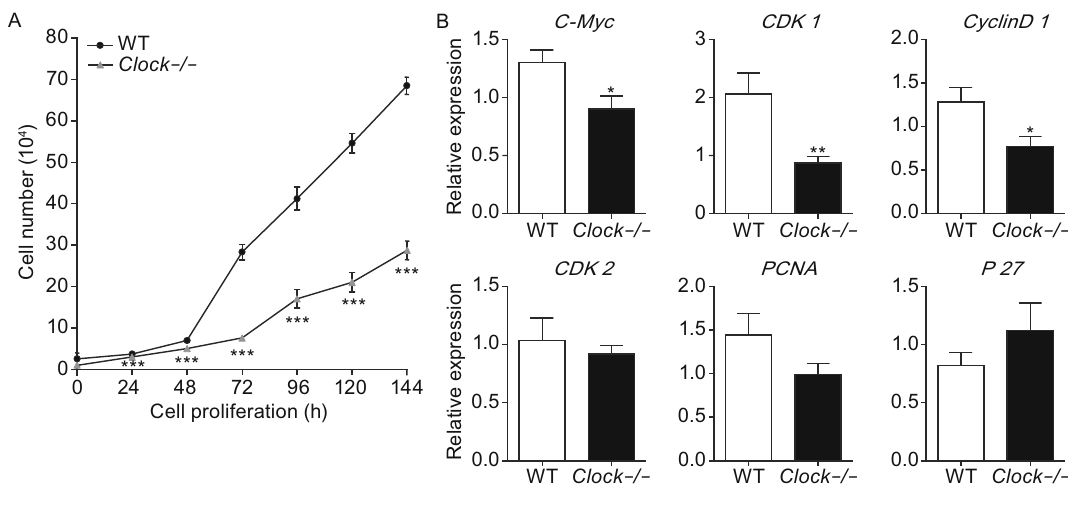
Figure 4. Clock silencing inhibited proliferation of mESCs. (A) Cell proliferation curve of the wild type and Clock -/- mESCs. Clock -/- mESCs exhibited signi fi cantly lower proliferation rate than that of the wild type mESCs. (B) Relative mRNA expression levels of cell cycle-related markers C-Myc, CyclinD1, CDK1, CDK2, PCNA, and P27 in wild type and Clock-/- mESCs. The mRNA expression levels were normalized to that of the endogenous GAPDH . Data represent an average of three independent experiments and are expressed as means ± S.D. Statistical signi fi cance was calculated using the Student ’ s t -test: * denotes P < 0.05, ** denotes P < 0.01, *** denotes P < 0.001 compared with the Ctrl group, ns, not signi